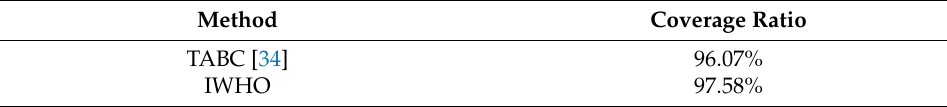
Table 11. Comparison of COOTCLCO and IWHO experimental